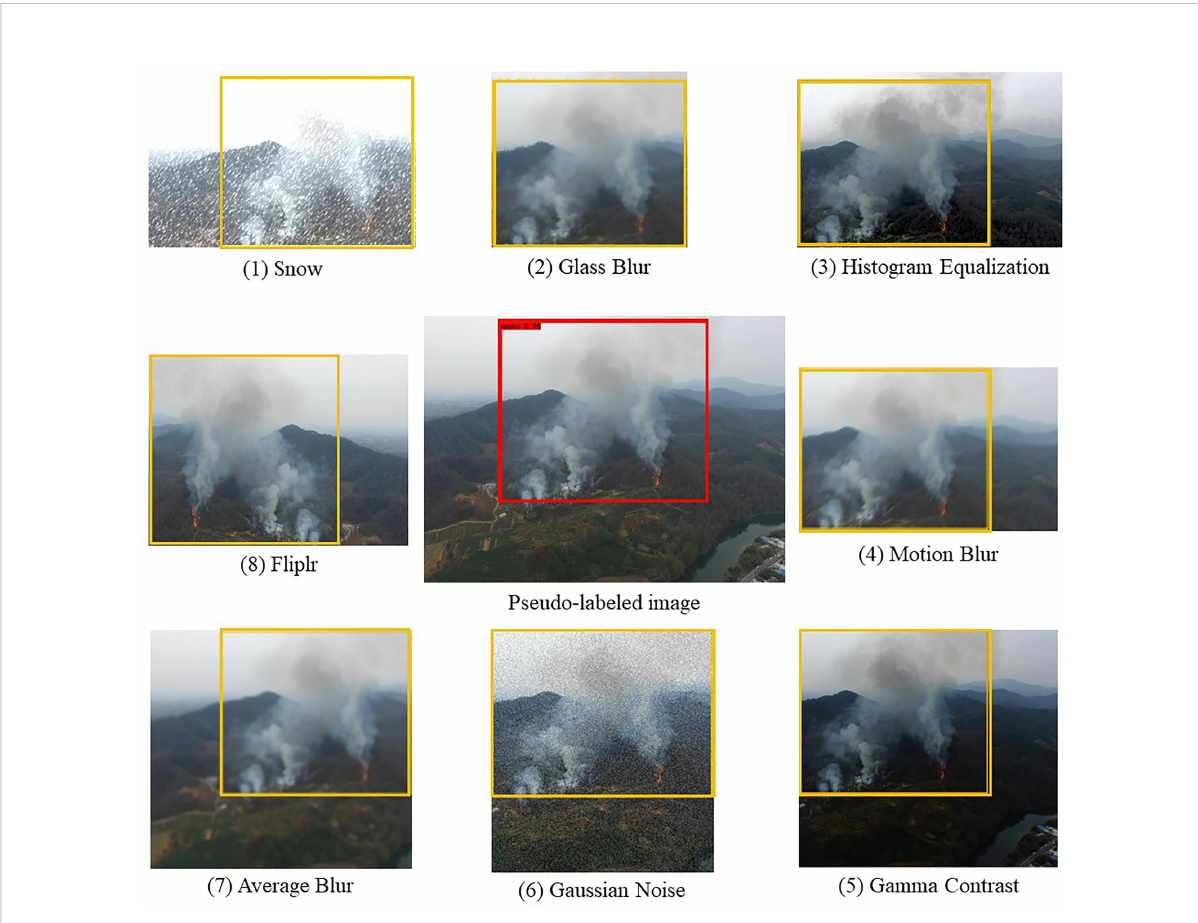
FIGURE 4 Examples of data augmentation and patch interception schemes used in the